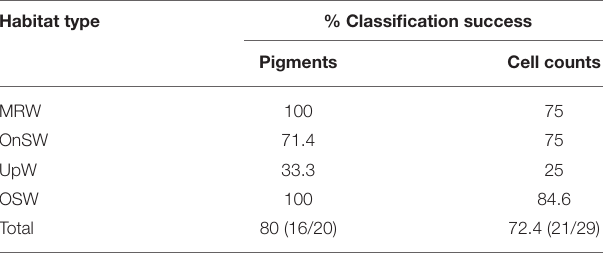
TABLE 3 | Classification success of pigment and cell count community samples to their predefined habitat types. Habitat type